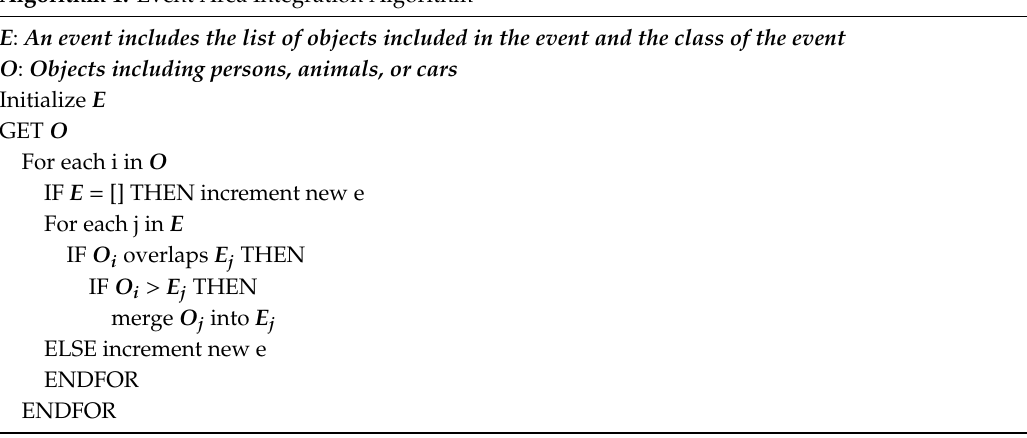
Figure 3. High-level event area extraction process. Algorithm 1. Event Area Integration